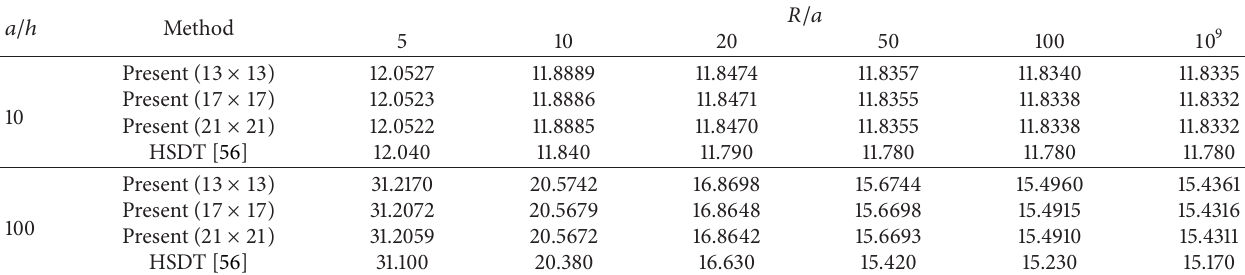
Table 2: Nondimensionalized fundamental frequencies of cross-ply laminated spherical shells, 𝜔 = 𝜔(𝑎 2 /ℎ)√𝜌/𝐸 2 , and laminate ( [0 ∘ /90 ∘ /90 ∘ /0 ∘ ] ).